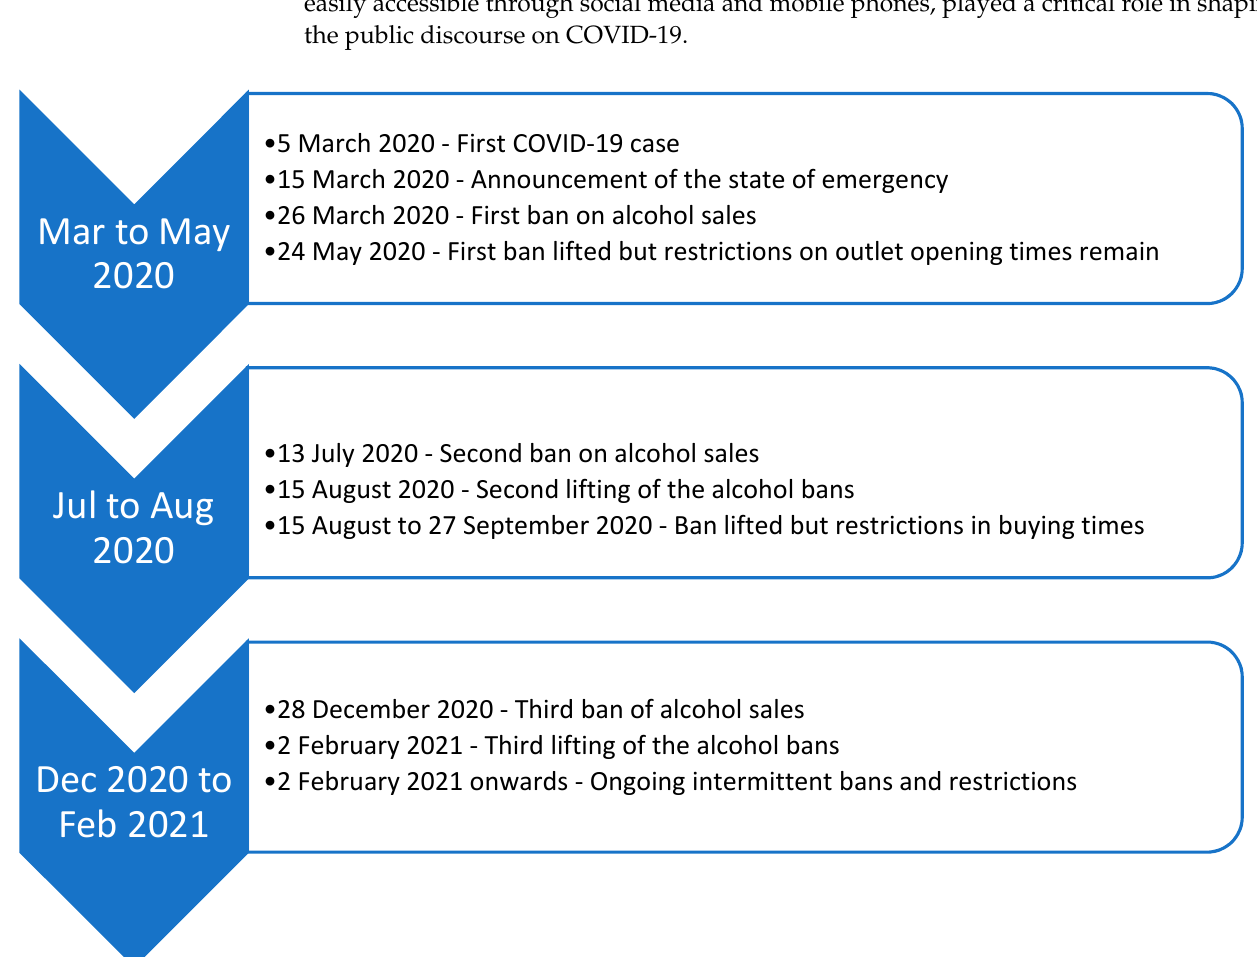
Figure 1. Timeline of events pertaining to the bans and trading hours restrictions of alcohol sales across the different levels of the COVID-19 lockdowns.